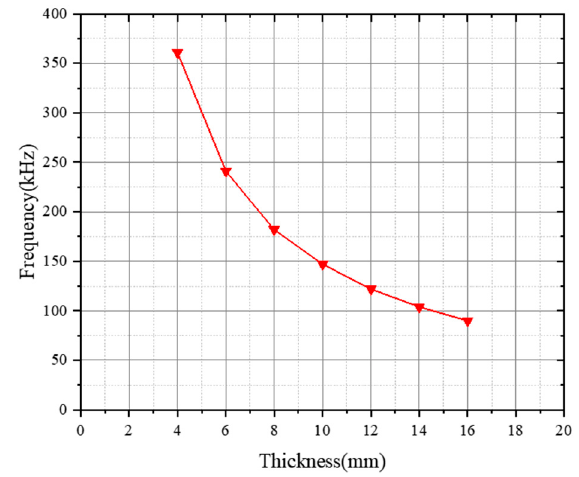
Figure 3. Curve of resonant frequency as a function of ceramic thickness.